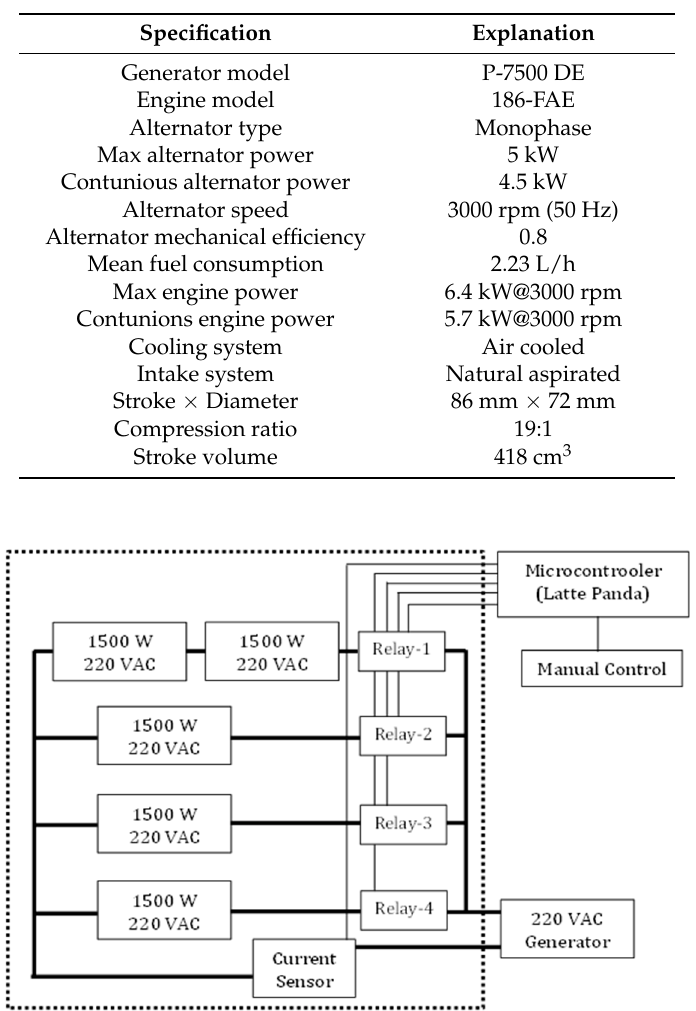
Table 1. General characteristics of the generator used in the experiment [36].